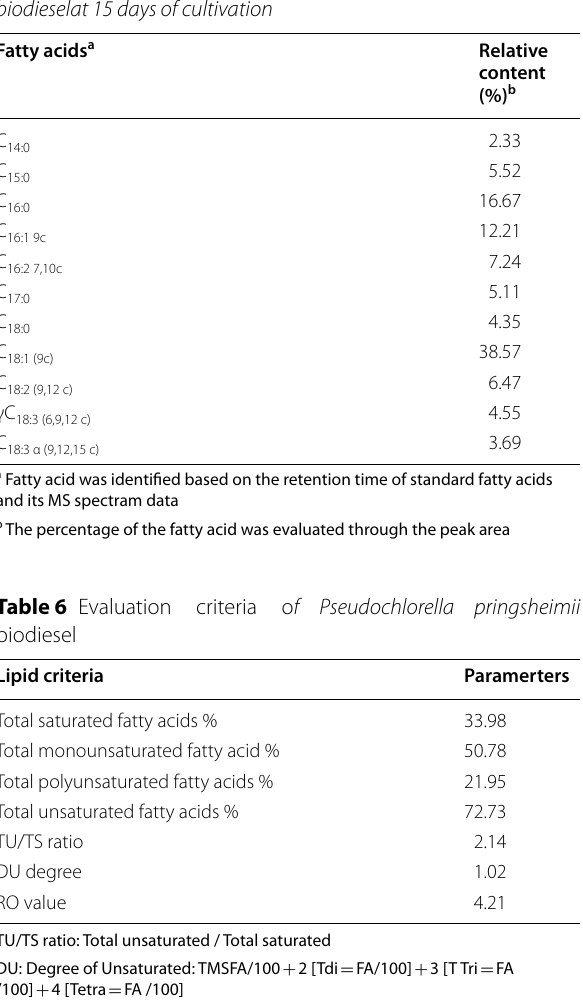
Table 7. The iodine value (IV 89.84